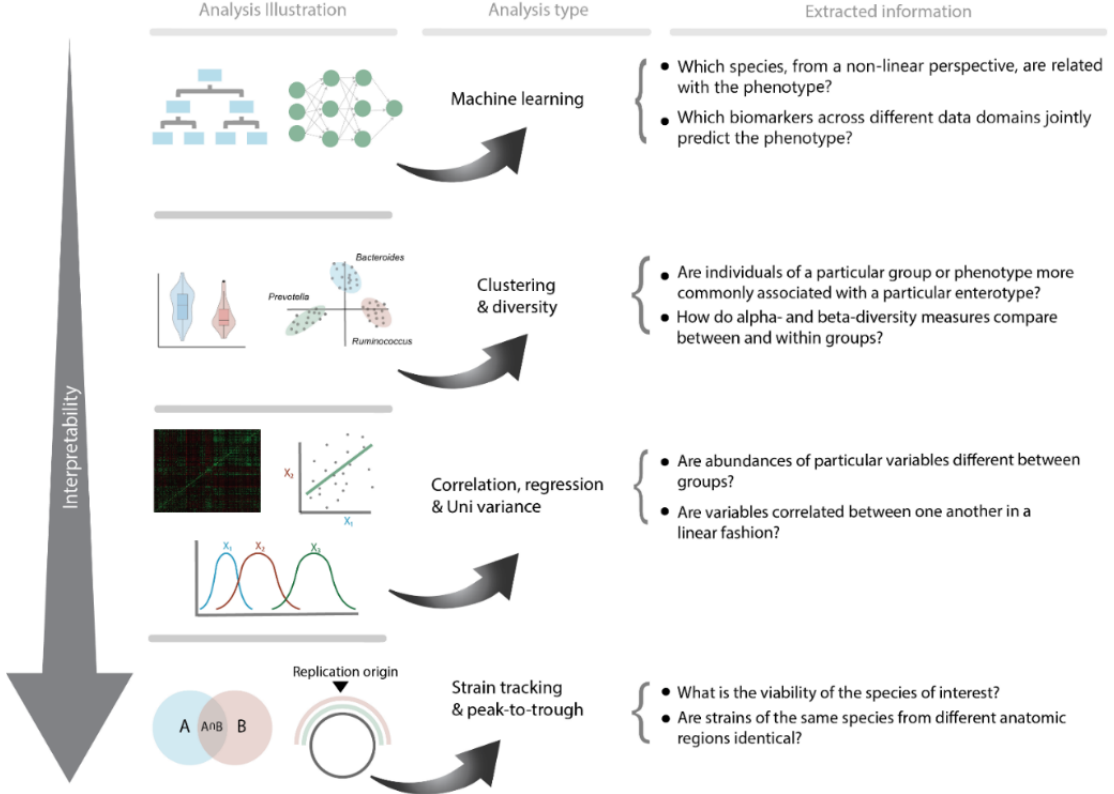
Figure 2. Overview of the most commonly used methodologies to examine microbiome data and the corresponding information accordingly.